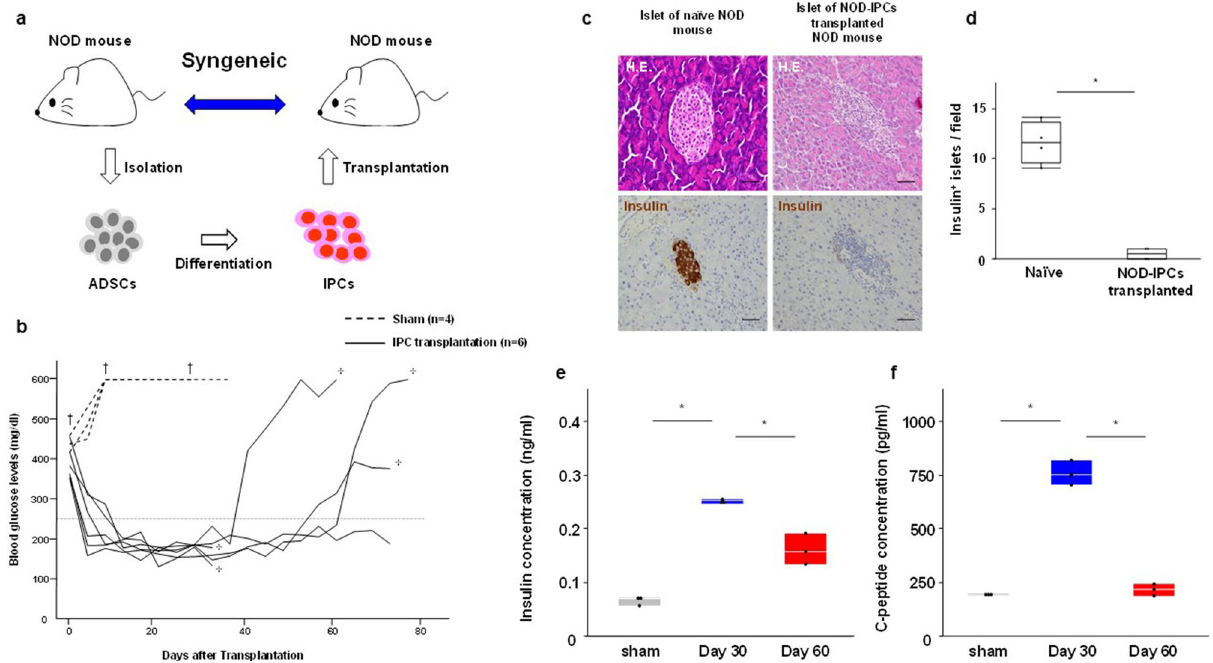
Figure 3. NOD-IPC transplantation. ( a ) Syngeneic model of NOD-IPCs transplantation. ( b ) Blood glucose (BG) concentration profile of NOD mice at the onset of diabetes after NOD-IPC transplantation. In the sham group ( n = 4), the BG concentration remained high. However, the BG concentration gradually decreased after NOD-IPC transplantation to < 200 mg/dL at 10 days post-transplantation and stayed low until 30 days post- transplantation ( n = 6). In three out of four recipient NOD mice, the BG concentration, which was improved by NOD-IPC transplantation, gradually increased to > 250 mg/dL 40–60 days after transplantation. †: death. ✢ : killed. ( c ) The islets of diabetic NOD mice transplanted with NOD-IPCs were not stained by the anti-insulin antibody. NOD mice that did not develop diabetes were used as controls. H&E staining. Scale bar, 100 μm. ( d ) The number of insulin-positive islets was significantly lower in NOD-IPC-transplanted NOD mice than in naïve NOD mice. The lines in the boxes show the median values (* P < 0.05, Mann–Whitney U test). ( e ) Serum insulin concentration in NOD mice transplanted with NOD-IPCs. The lines in the boxes show the median values (* P < 0.05, one-way ANOVA followed by the Tukey–Kramer test). ( f ) Serum C-peptide concentration in NOD mice transplanted with NOD-IPCs. The lines in the boxes show the median values (* P < 0.05, one-way ANOVA followed by the Tukey–Kramer